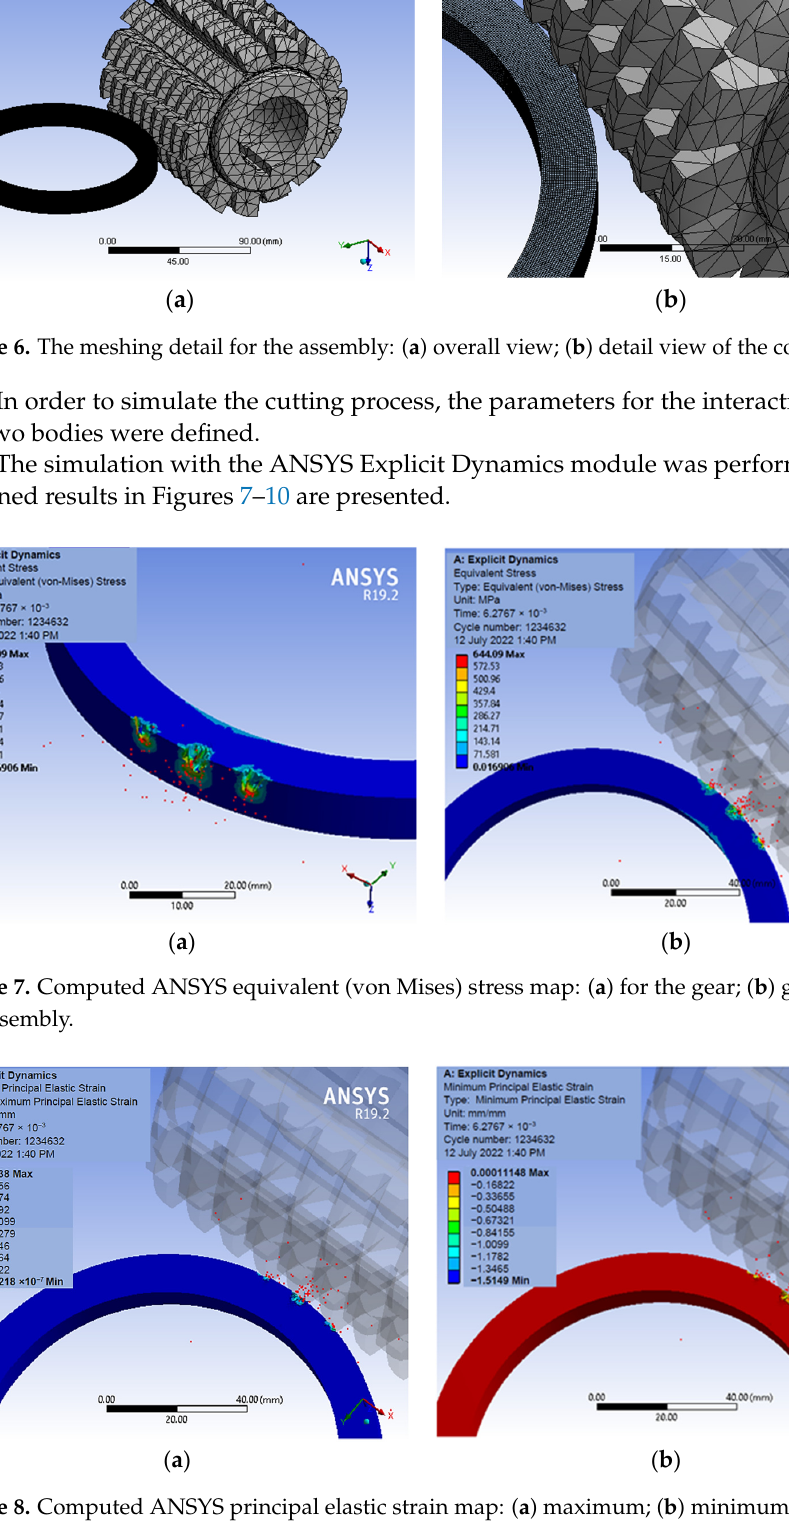
Figure 9. Computed ANSYS principal stress map: ( a ) maximum; ( b ) minimum.